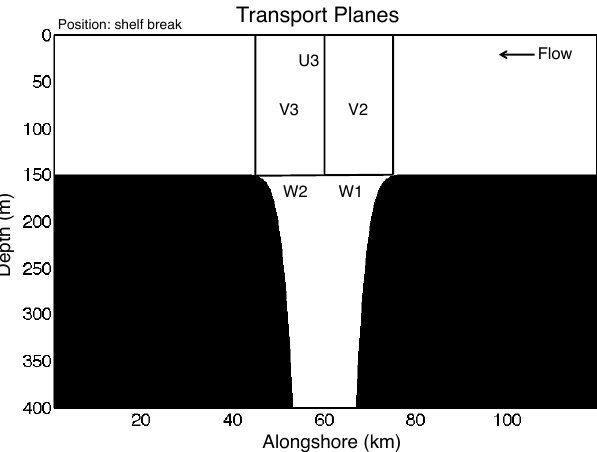
Figure 3. Planes used for transport